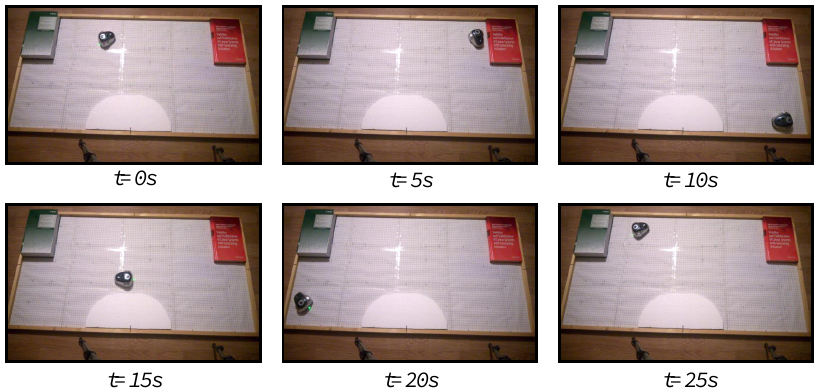
Figure 12. Experiment 3. Wall following algorithm using event-based architecture with ¯ e = 15%.